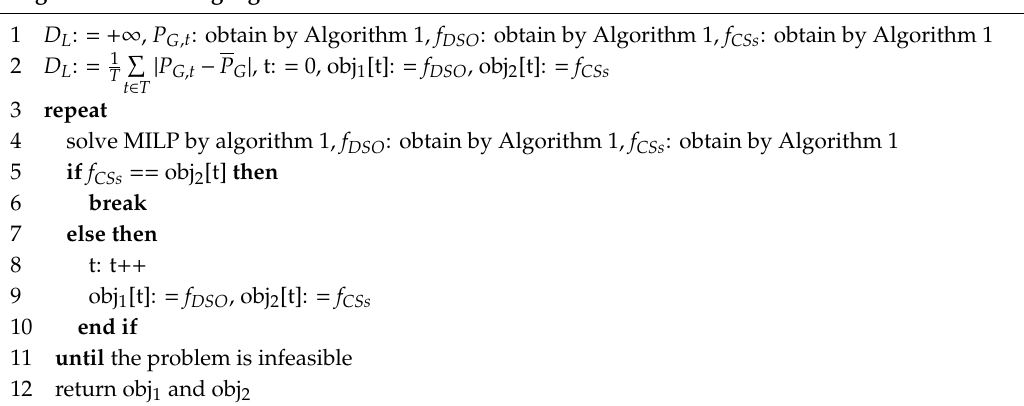
Algorithm 3: Scaling algorithm